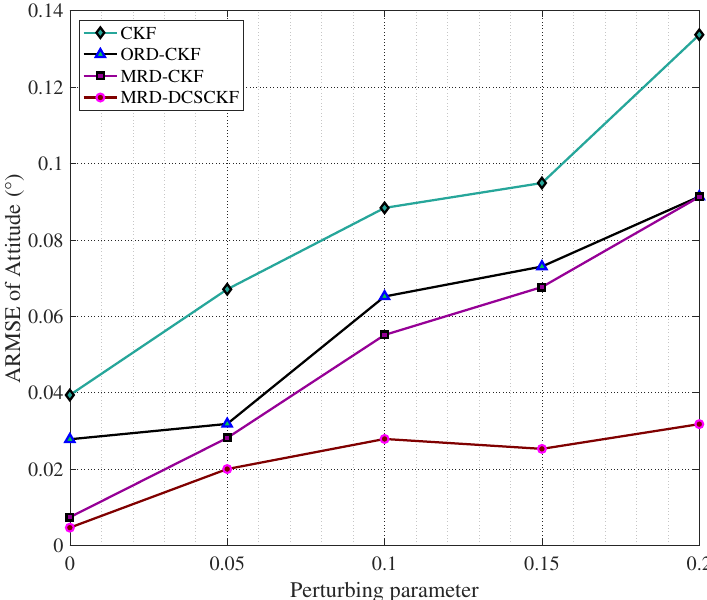
Figure 22. ARMSEs of attitude under different perturbing parameters.